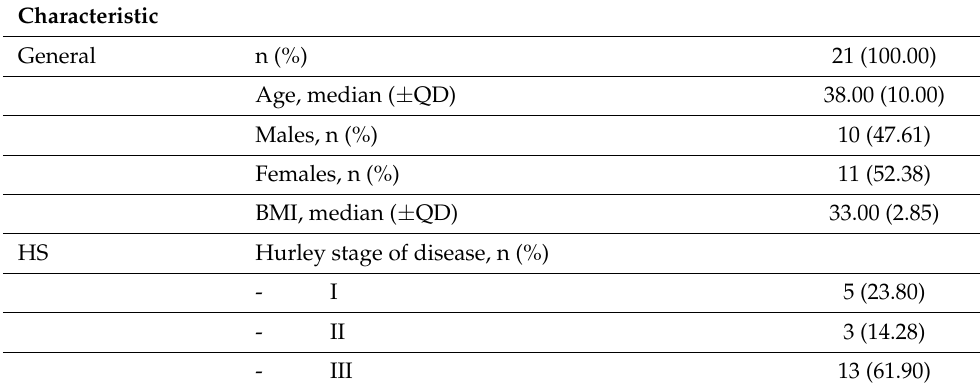
Table 1. General and clinical characteristics of the study